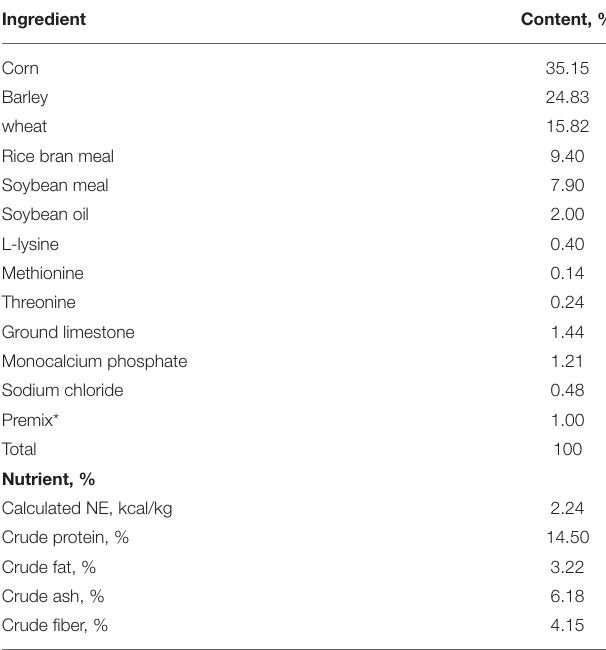
TABLE 1 | Composition and nutrient analysis of basal